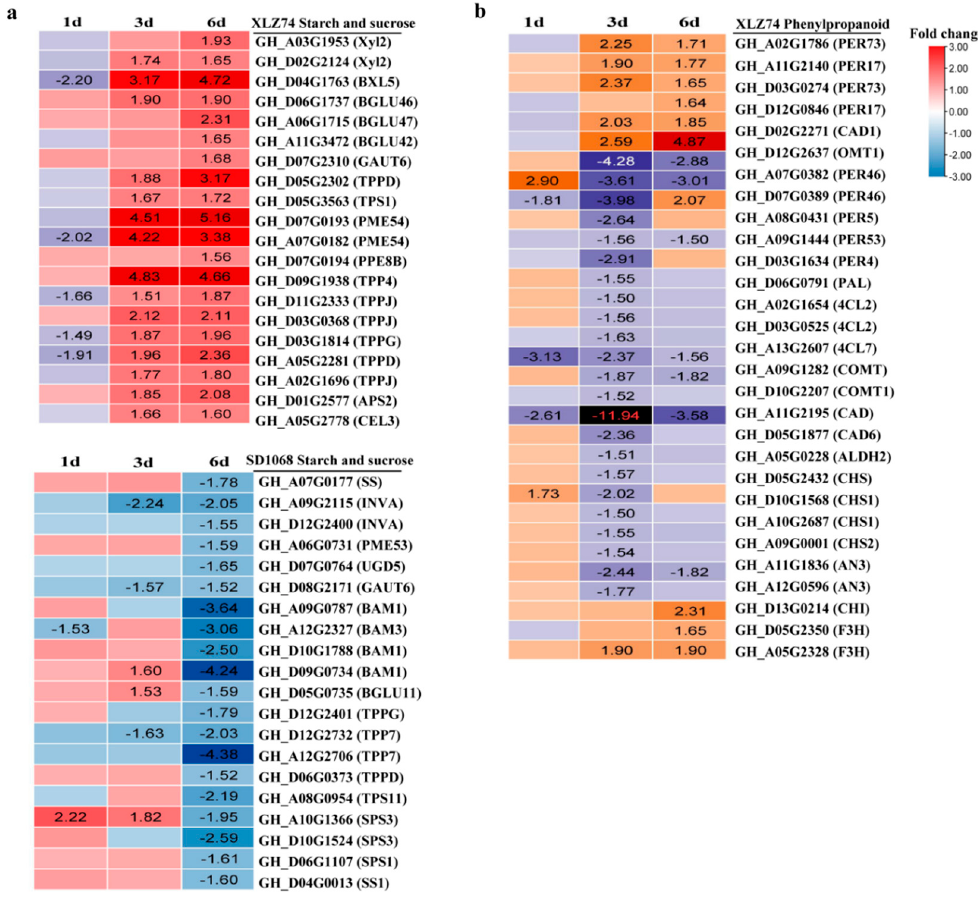
Figure 11. The expression patterns (RNA-seq based data) of starch and sucrose metabolism and phenylpropanoid metabolism-related genes. ( a ) Heatmap showing the expression patterns of the genes related to starch and sucrose metabolism in XLZ74 (top panel) and SD1068 (bottom panel). ( b ) Heatmap showing the expression patterns of the genes related to phenylpropanoid metabolism in XLZ74. The number in box indicates the expression fold change of the gene (only those with a ≥ 1.5-fold difference are shown). MC-induced downregulated and upregulated expression are indicated by blue and red colors, respectively. All the numbers in heatmap were fold